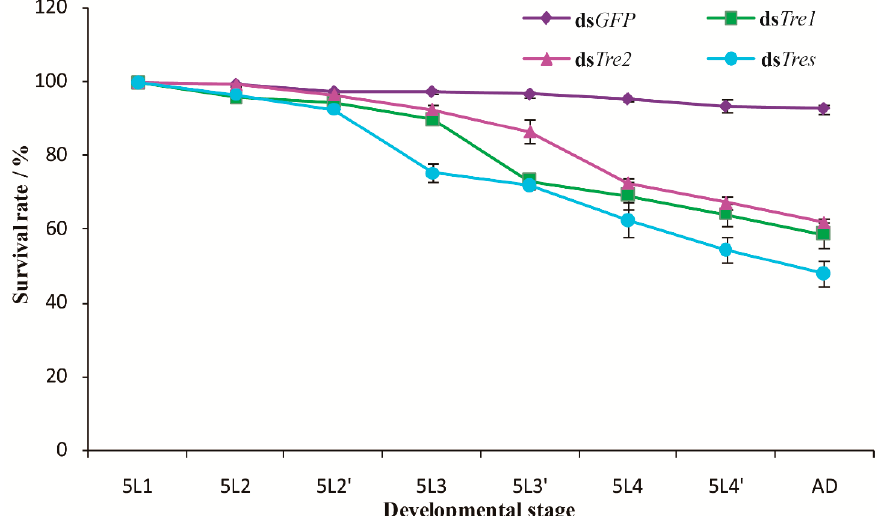
Figure 7. Survival rates of S. furcifera following RNAi. Data are presented as means ± standard error from three biological replicates with 50 insects in each group. The age in days of the insects is indicated; for example, 5L1 indicates the first day of fifth-instar nymphs; 5L2 and 5L2 ′ represent the two 12 h in the first day. AD, adults; ds Tres , ds Tre1 + ds Tre2 .